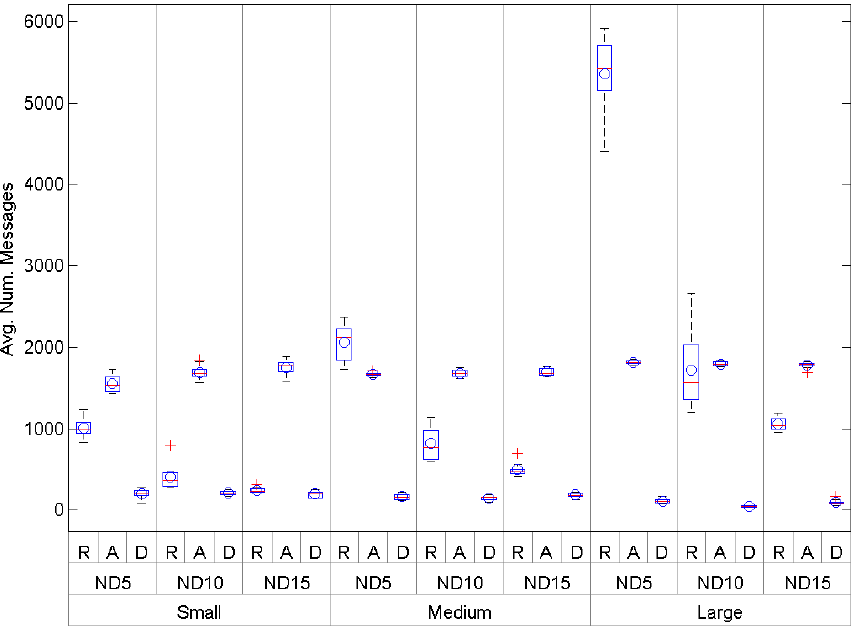
Figure 13. Average number of messages to set-up the network for small-, medium- and large-size scenarios considering AODV . Table 4. Average number of messages sent during the set-up phase in small-size